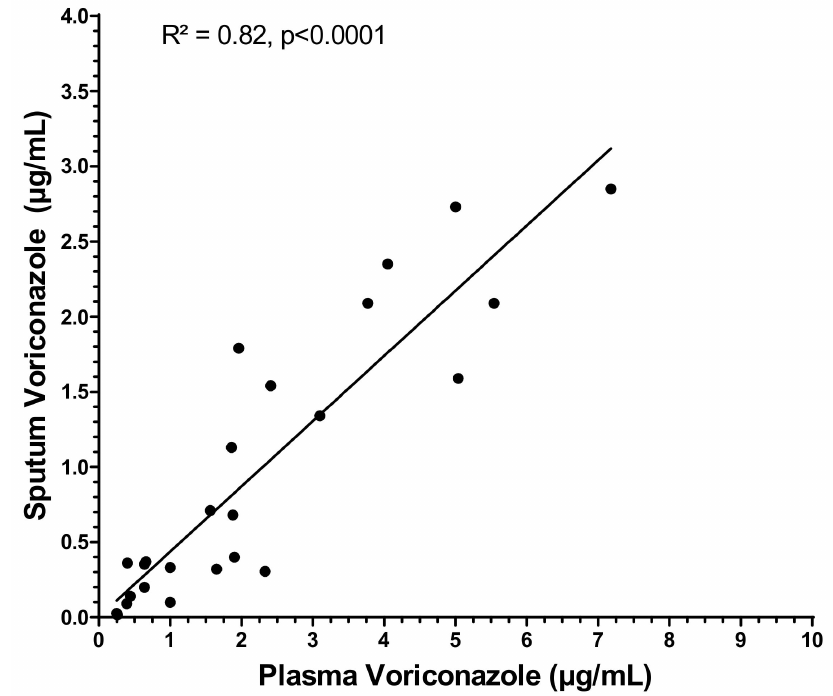
Figure 2. Correlation between plasma and sputum voriconazole concentrations. When available, the sputum concentration was compared to the minimum inhibitory concentration (MIC) of Aspergillus spp. or the epidemiological cut-off (ECOFF) value of 1 mg/L according to ESCMID guidelines [19]. All isolates were voriconazole-susceptible. Sputum C min was higher than MIC in 48% of cases compared to 68% in plasma (Figure